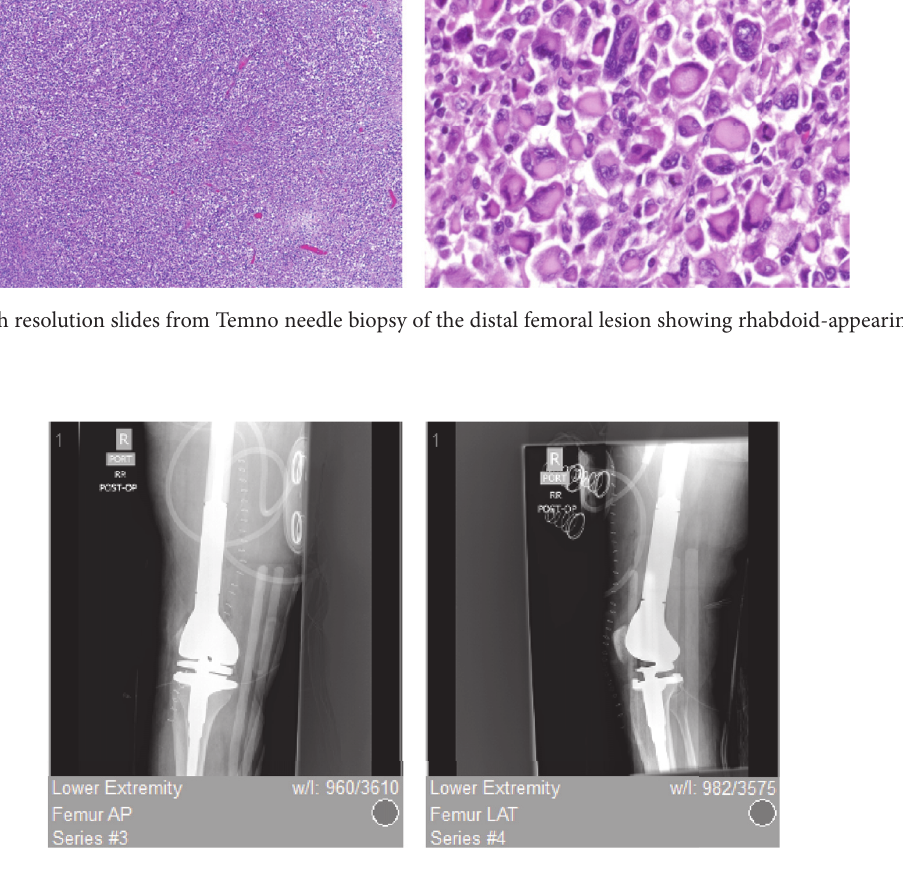
Figure 3: Figure 3 shows postoperative AP/lateral radiographs status, after wide resection of the lesion and replacement with distal femoral